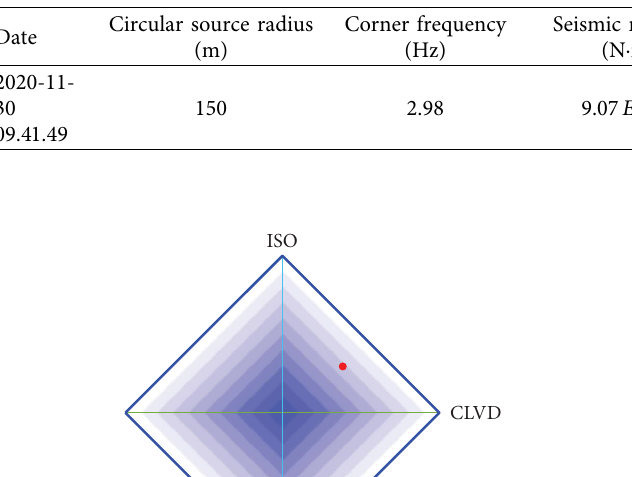
Figure 13: Recording of strong tremor signals on November 30, 2020, at 09:41:49. Table 1: Results of seismic source parameters solution.